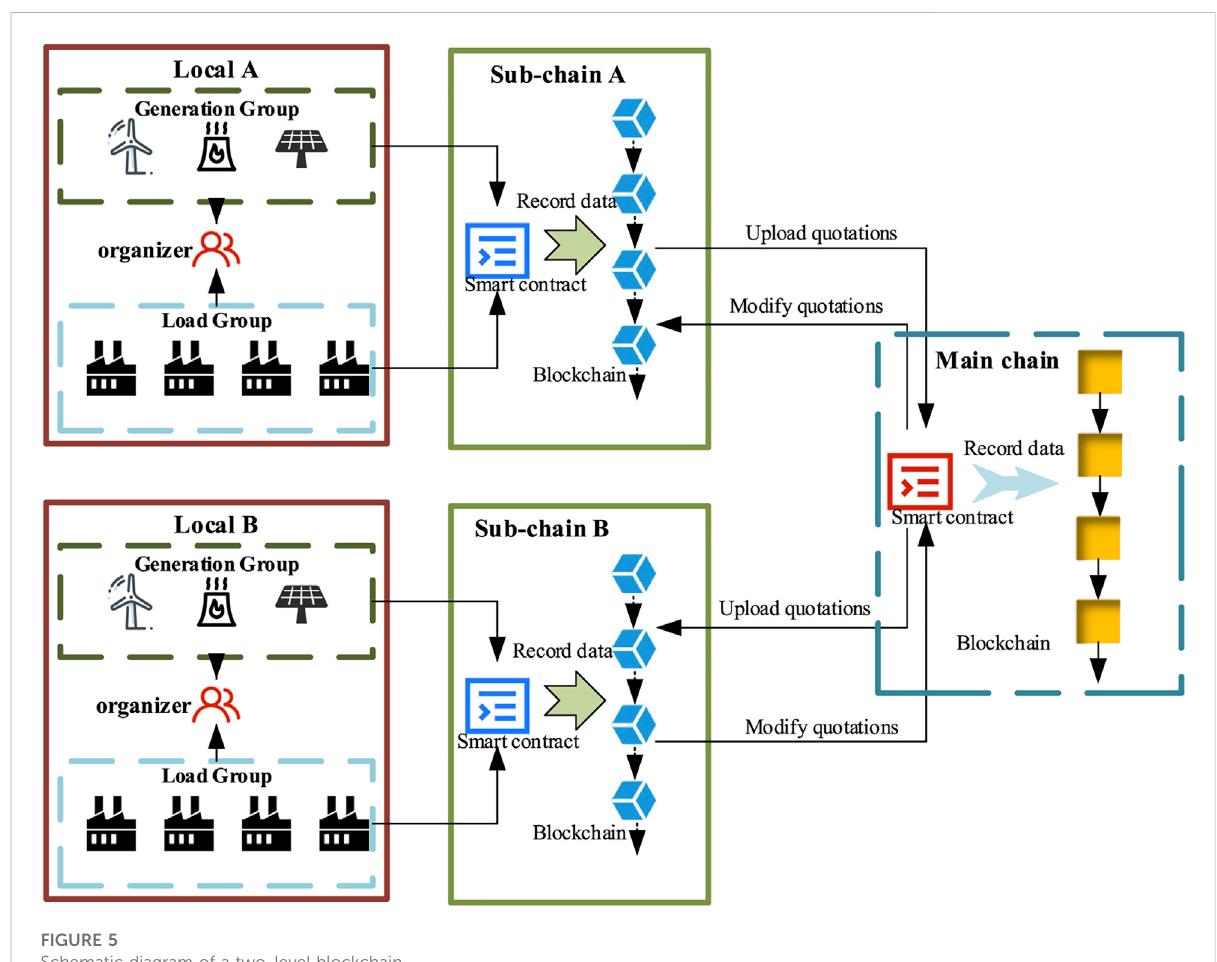
FIGURE 5 Schematic diagram of a two-level